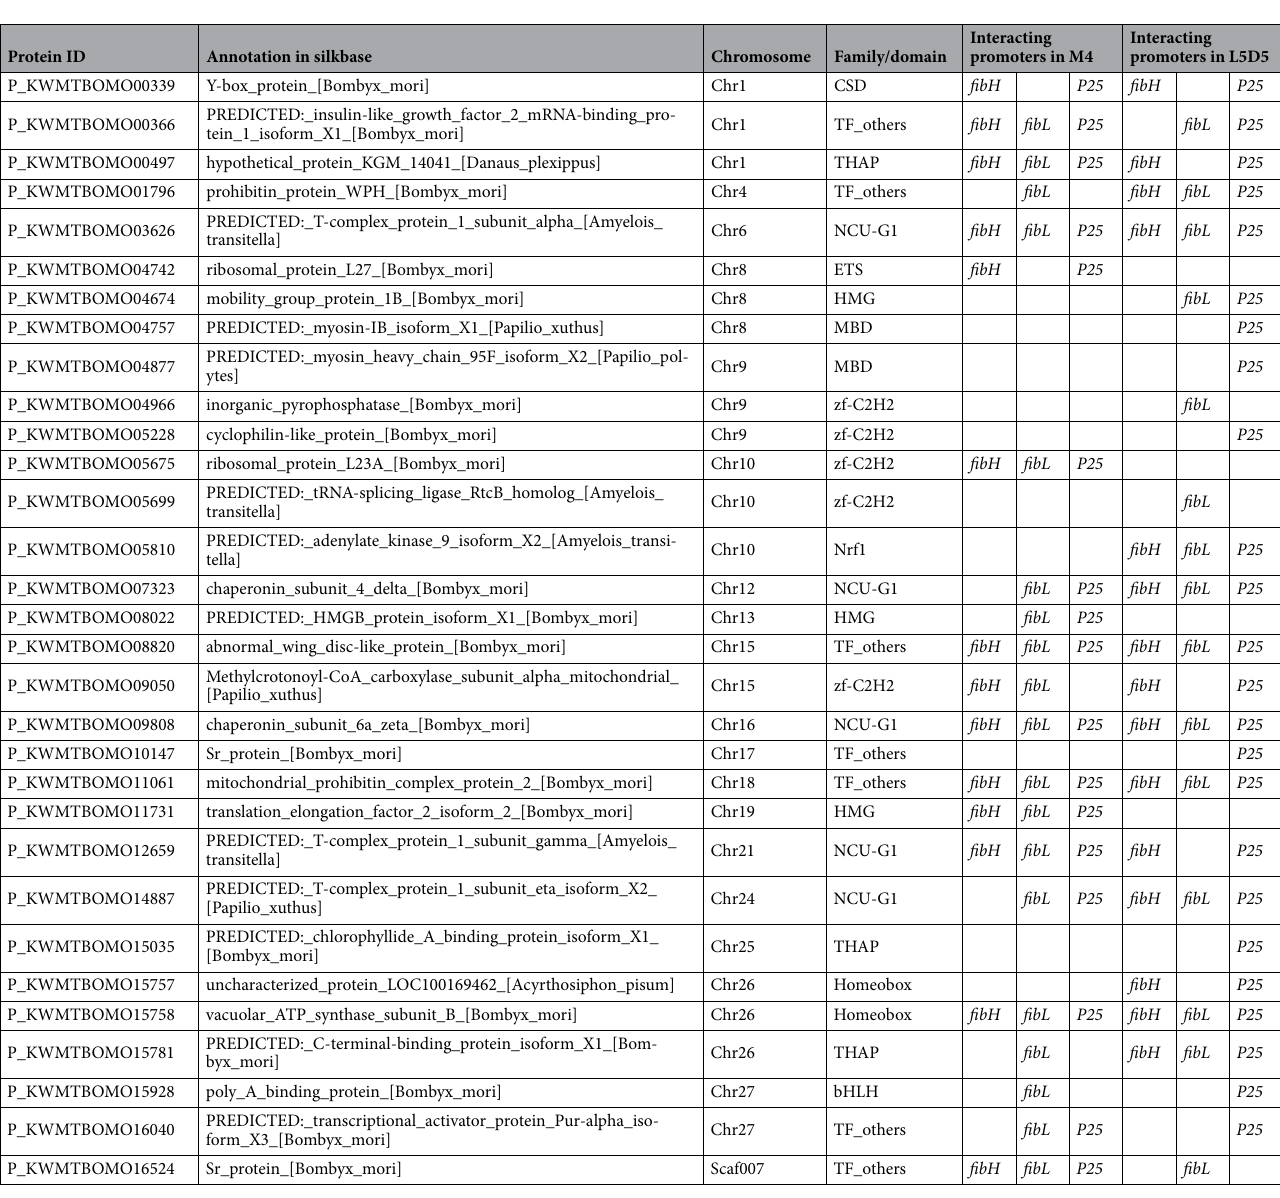
Table 2. Potential TFs identified from the PIPs of fibroin